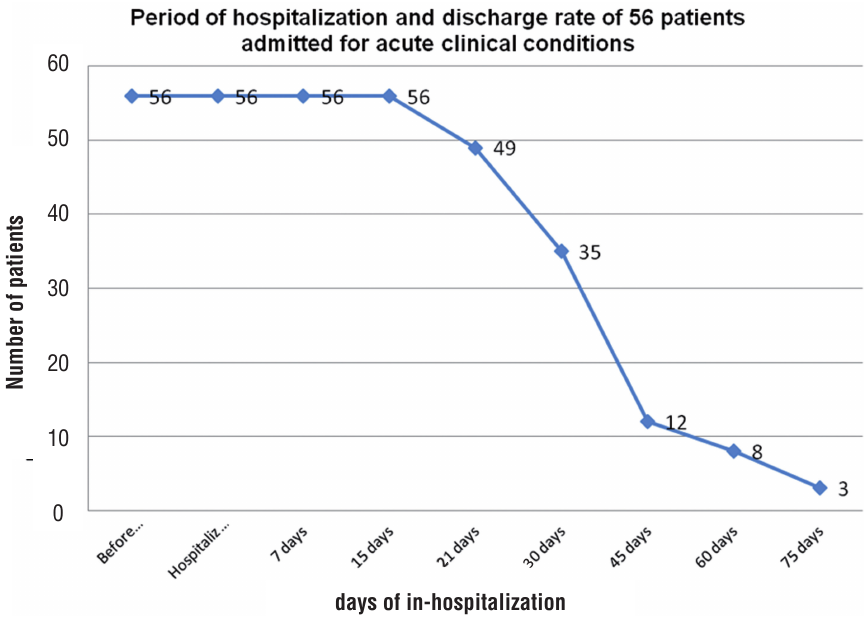
figure 2 - flowchart of Acute urinary Retention in 56 patients admitted to hospital due to other than urological